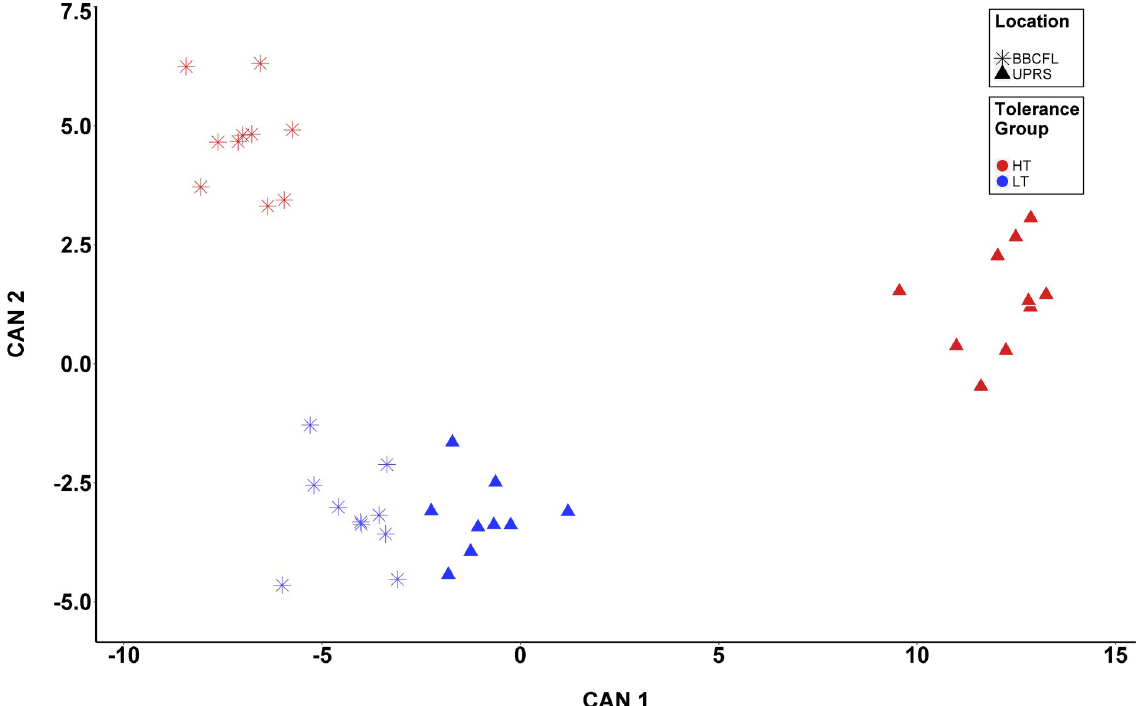
Fig 4. Canonical discriminant analysis (CDA) for response to fescue toxicosis. CDA was performed to discriminate animals based on the combination between tolerance group (T; High [HT] and Low [LT] tolerance groups) and location (BBCFL and UPRS) using 14 fungal and bacterial OTUs. Each point represents the canonical score (CS) of each animal based on the respective canonical variable (CAN). The x-axis represents CAN 1 and the y-axis CAN 2. Red and Blue points represent HT and LT animals, respectively, whereas triangles and stars represent animals from UPRS and BBCFL,